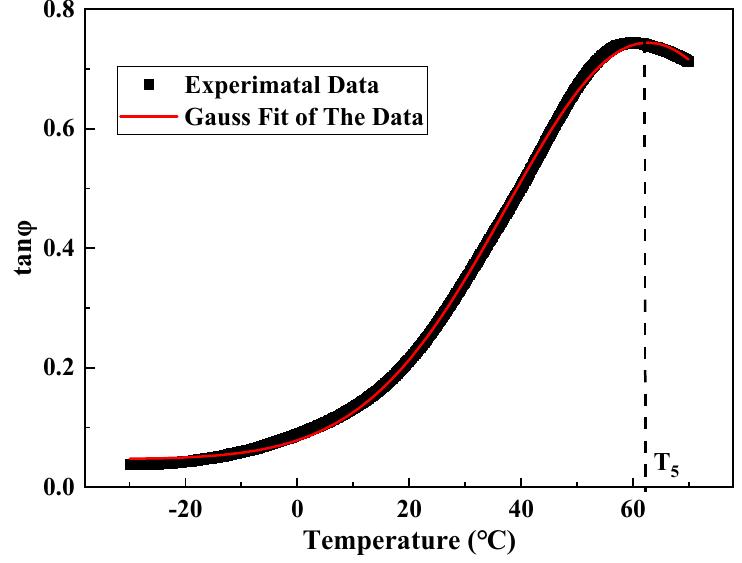
Figure 8. Schematic of the phase angle feature points.